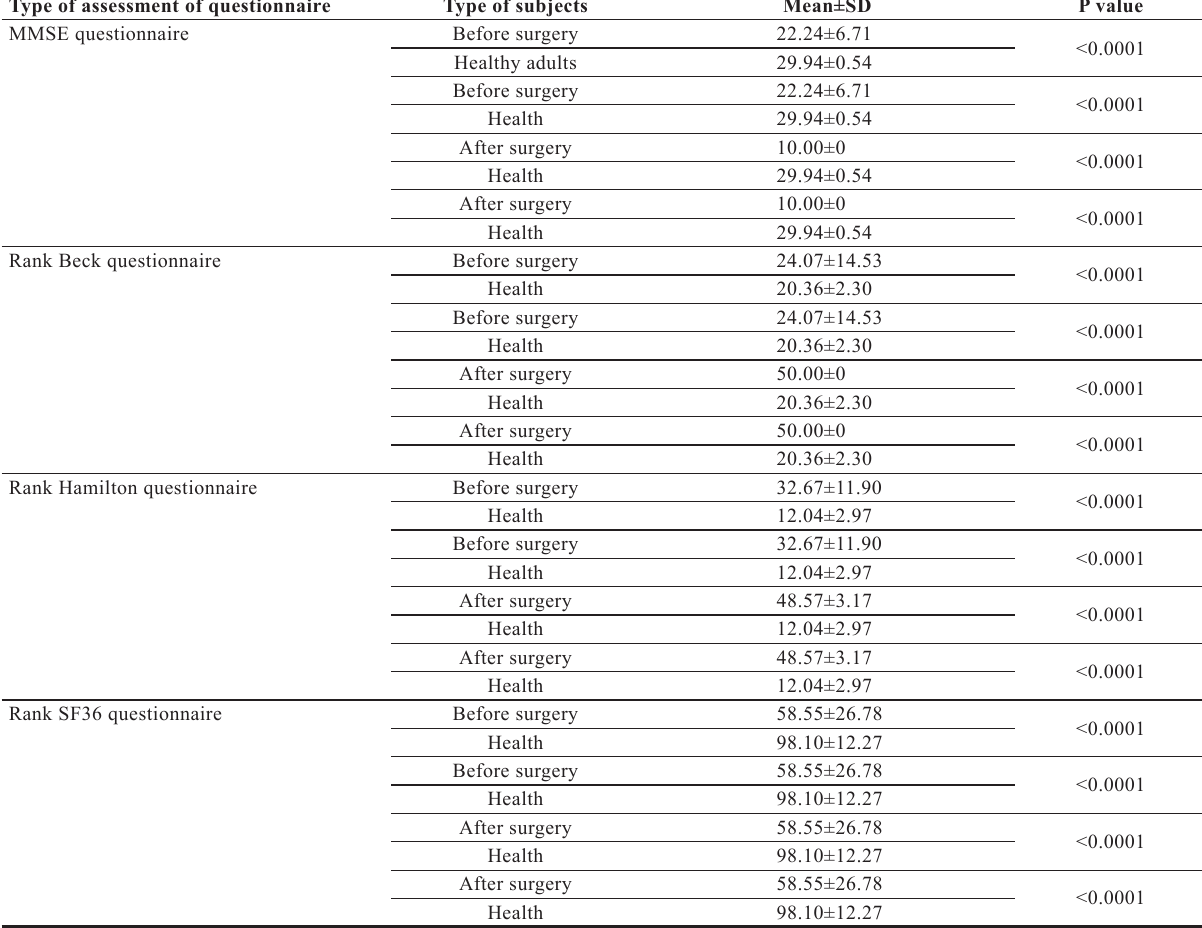
Table 3. Comparative assessment of cognitive impairment, depression, anxiety and quality of life in brain tumor patient before and after surgery with healthy adults according equal variance assumed and not